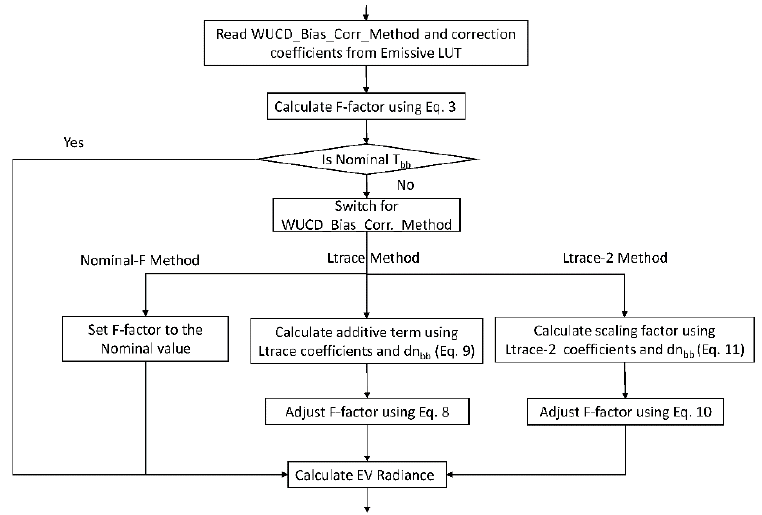
Figure 1. Flowchart of the VIIRS operational warm-up/cool-down (WUCD) bias correction in the NOAA operational processing. TEB calibration precedures that are not changed are omitted.